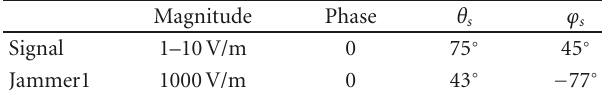
Table 1: Parameters for the desired signal and interferer.